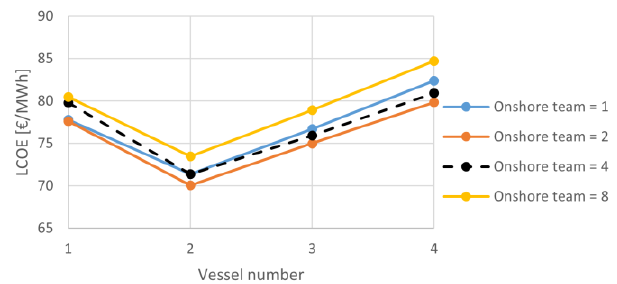
Fig. 26. LCOE versus vessel number for various numbers of onshore teams, in the case of c/d time=1.5 hr and assembly team=3.